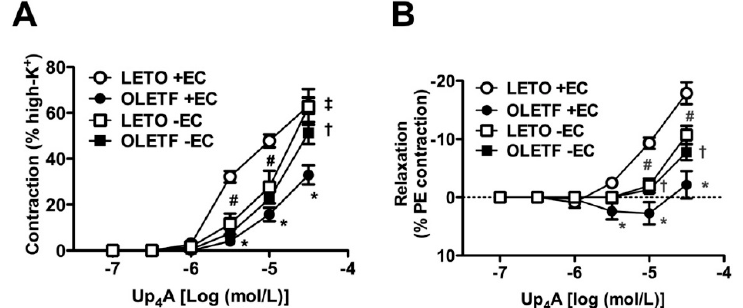
Figure 1. Contribution of the endothelium to cumulative applications of uridine adenosine tetraphosphate (Up 4 A) in the aortas of LETO and OLETF rats under basal conditions or after being precontracted with phenylephrine (PE). Concentration-response curves for Up 4 A in endothelium-intact (+EC) and -denuded ( − EC) aortas under basal conditions ( A ) or precontracted with PE (10 − 6 mol/L). ( B ) The points show the means ± standard errors as percentages of the contraction normalized by high K + (80 mmol/L) ( A ) or as percentages of the relaxation of the contraction induced by PE (10 − 6 mol/L) ( B ). n = 5–6. * p < 0.05,